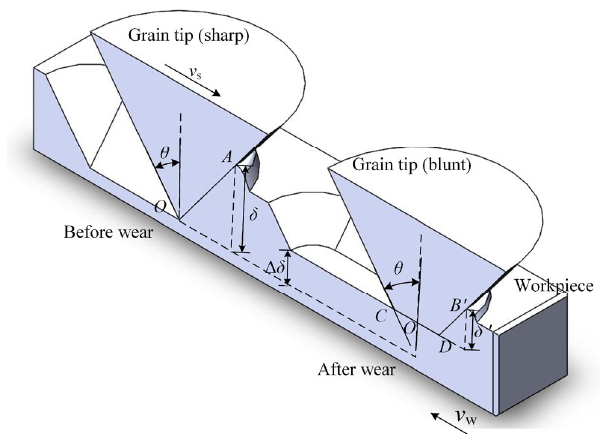
Fig. 5 Wear height of a single